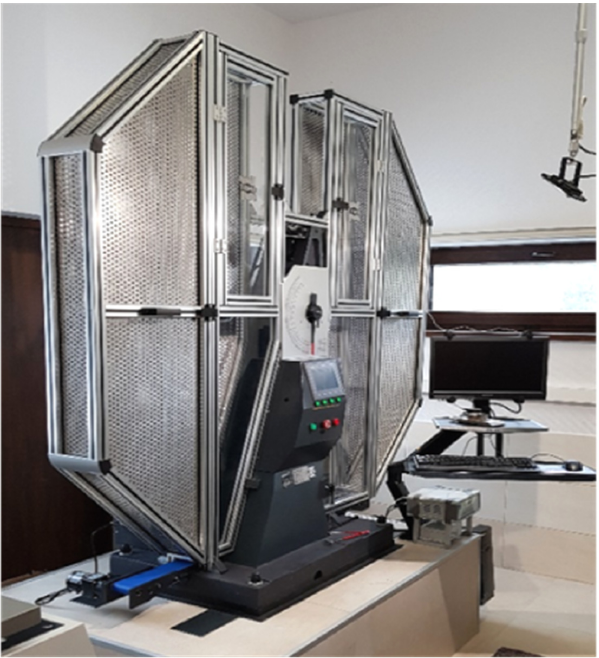
Figure 5. Instrumented Charpy pendulum used to conduct the tests.